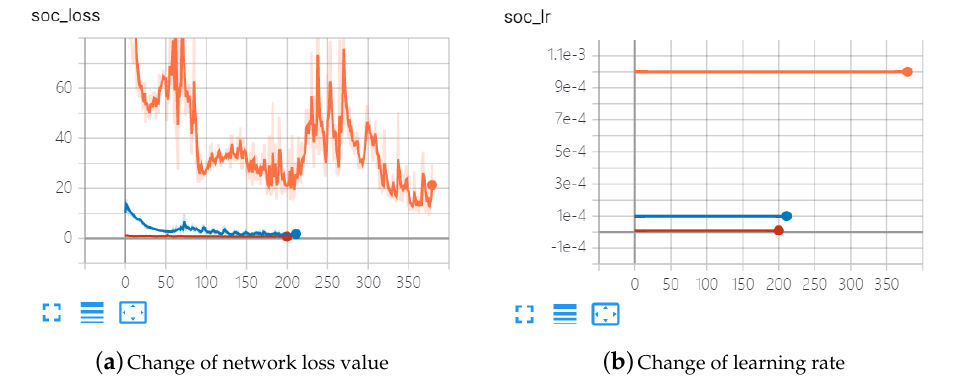
Figure 10. Change trend of loss value during training